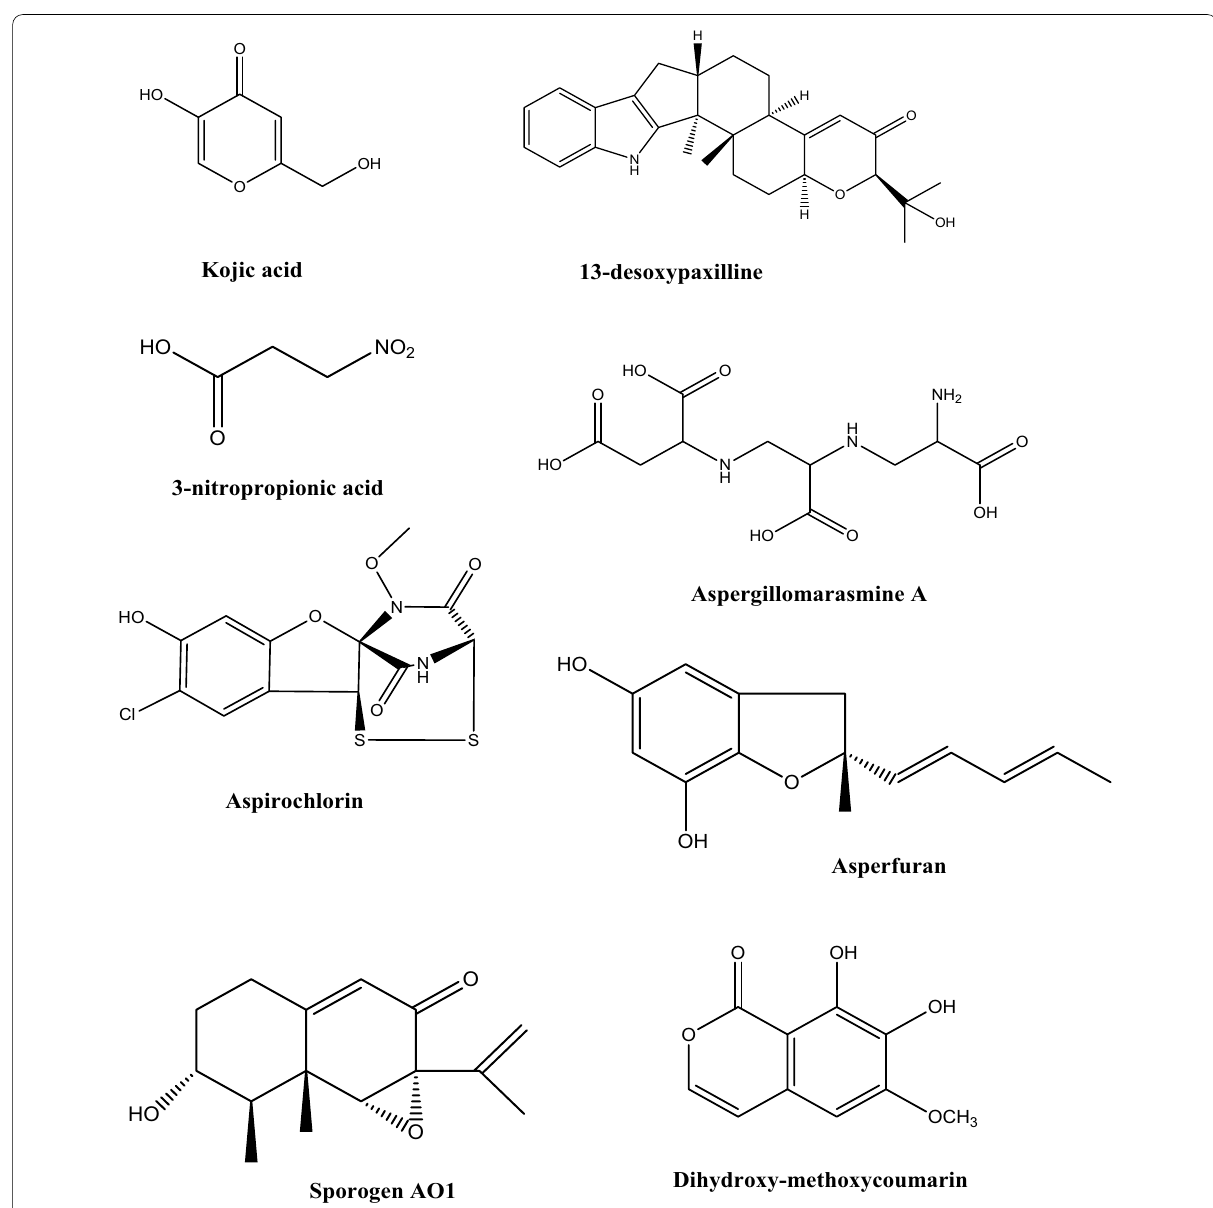
Fig. 2 Some secondary metabolites produced by A.